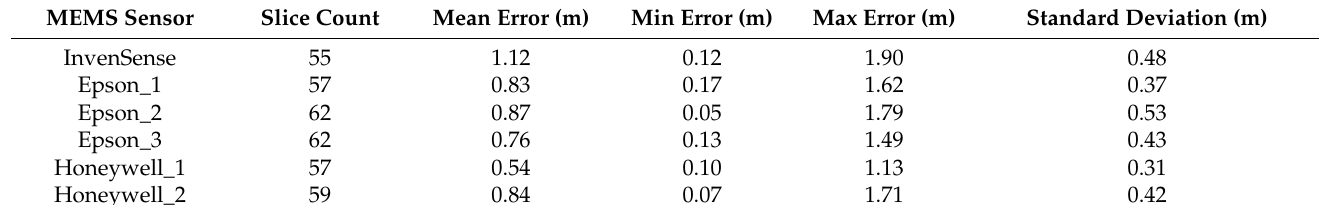
Table 4. Accuracy statistics—10 s slice length.